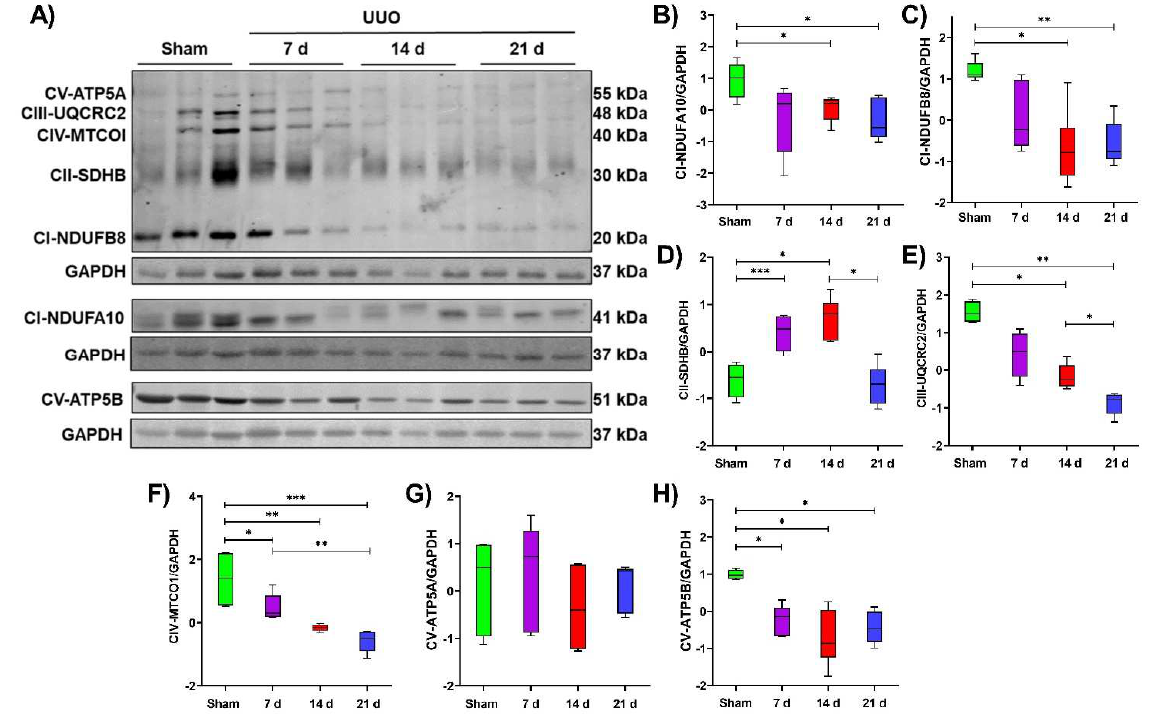
Figure 4. Representative OXPHOS protein levels in the temporal course of the unilateral ureteral obstruction (UUO). ( A ) Representative blots and ( B – H ) statistical analysis of the levels CI–NDUFB8, CI–NDUFA10, CII–SDHB, CIII–UQCRC2, CIV–MTCOI, CV–ATP5A, and CV–ATP5B subunits of the oxidative phosphorylation (OXPHOS) during 7, 14, and 21 days after UUO; glyceraldehyde 3–phosphate dehydrogenase (GAPDH) used as a loading control. All Western blot measurements were performed in whole tissue lysate. Data are represented as mean ± SD of two technical replicates from three rats per group; each technical replicate was standardized Z(µ = 0, σ). * p < 0.05, ** p < 0.01, *** p < 0.001.